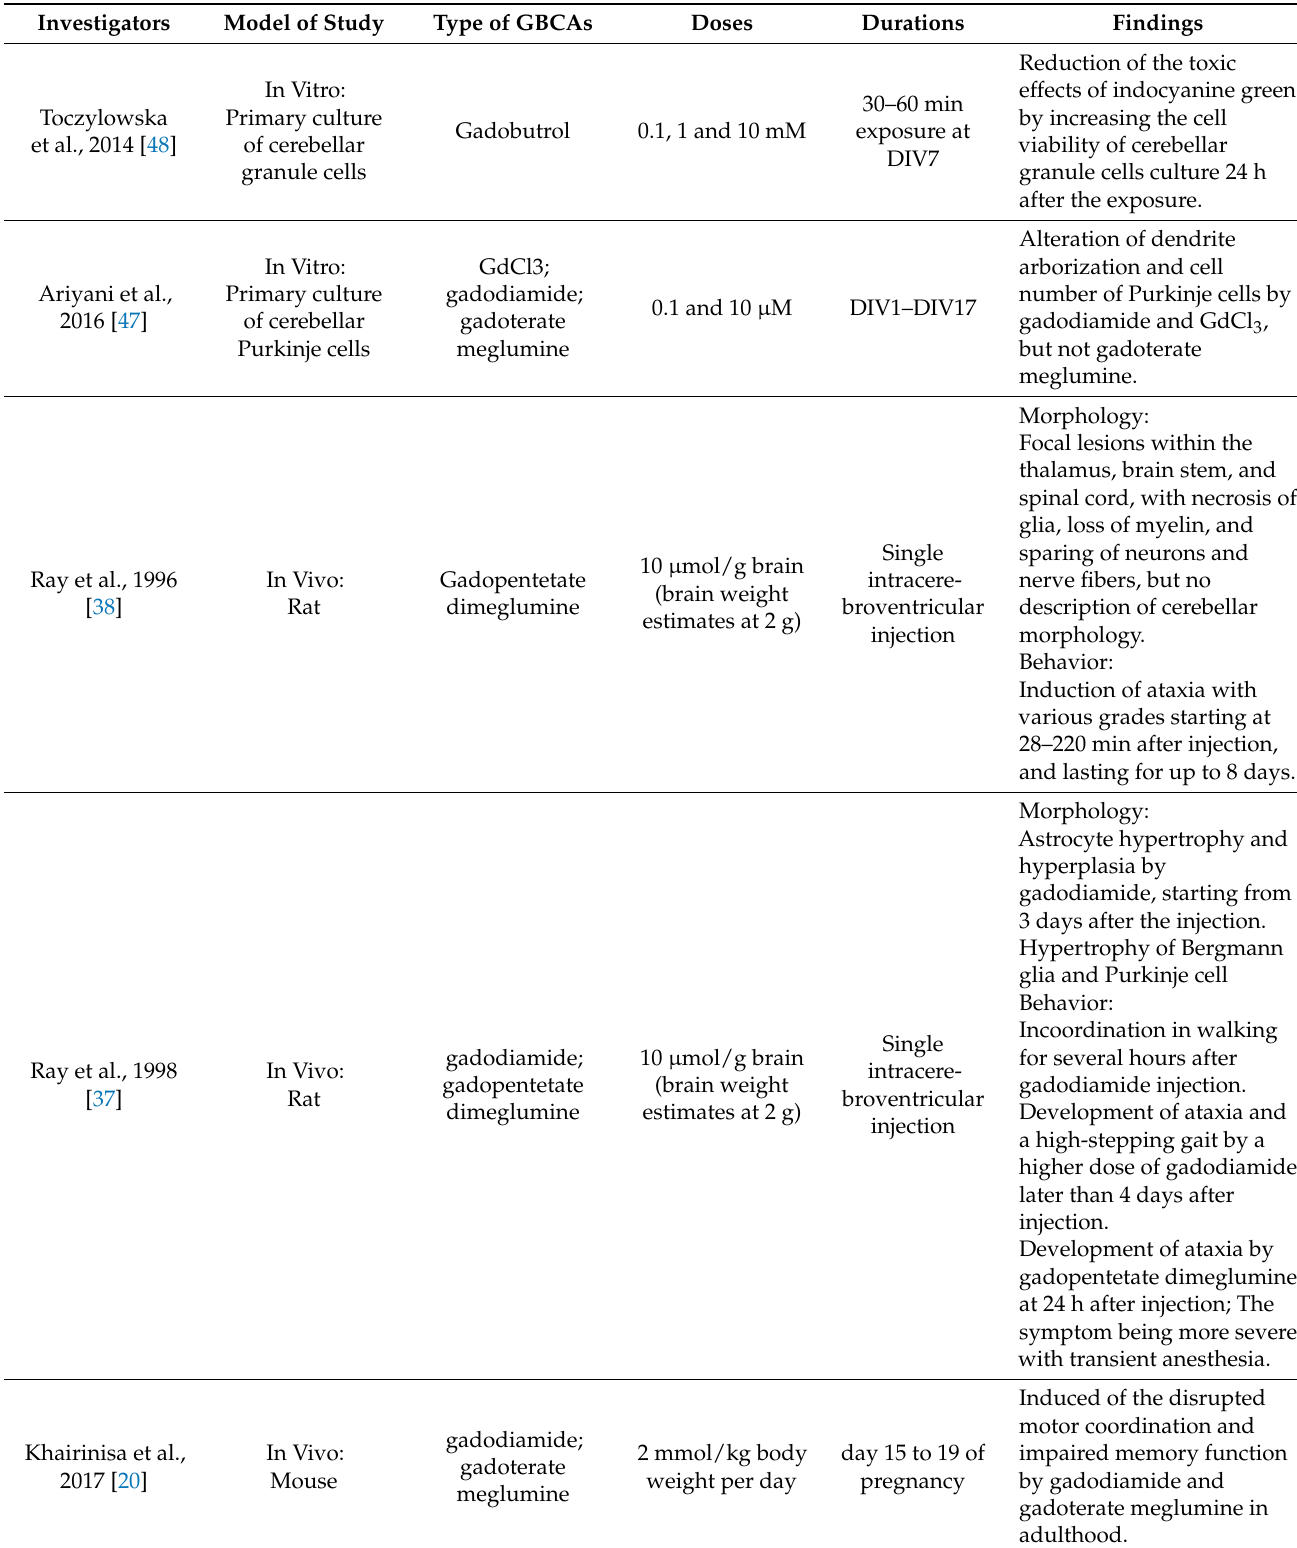
Table 1. Representative in vitro and in vivo studies investigating the cerebellar neurotoxicity of